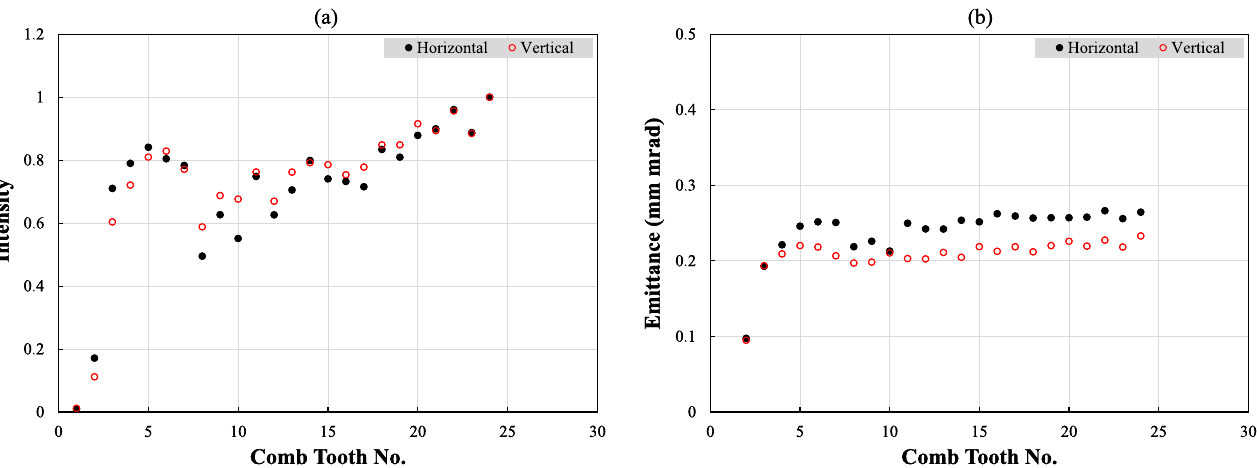
FIG. 12. Calculated beam parameters from the phase space distributions measured within the ramp-up of the 1.4-MW H − beam macropulse. Time difference between comb teeth is ∼ 4 . 7 μ s (5 minipulses). (a) Normalized intensities. (b) Emittance